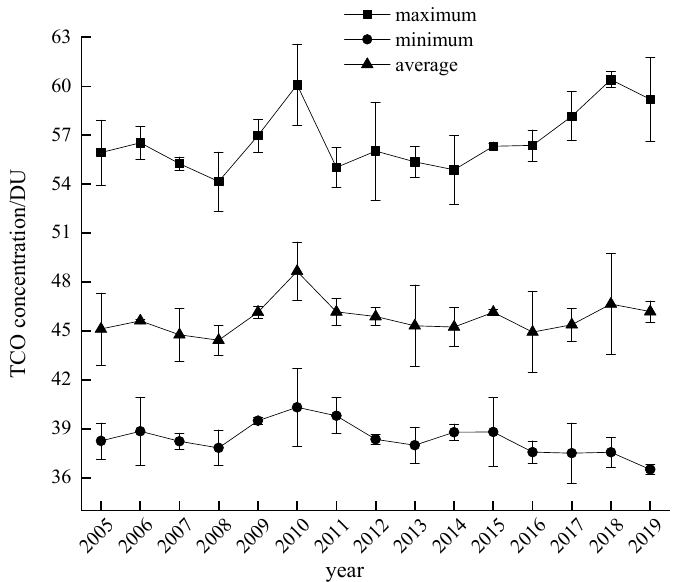
Figure 3. Maximum, minimum, and average values of TCO concentration in China (mean ± se).